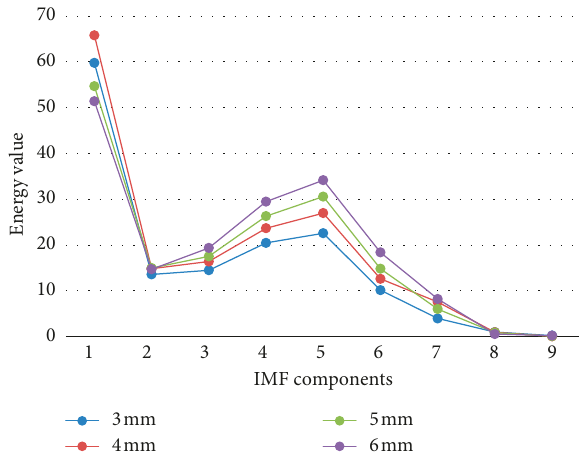
Figure 15: The IMF component energy values at different leak aperture size.